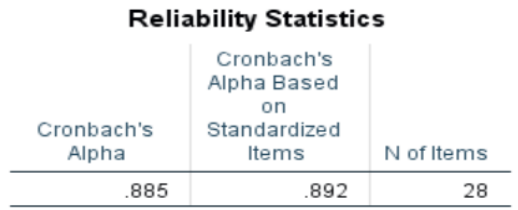
Figure 20. Cronbach’s alpha.